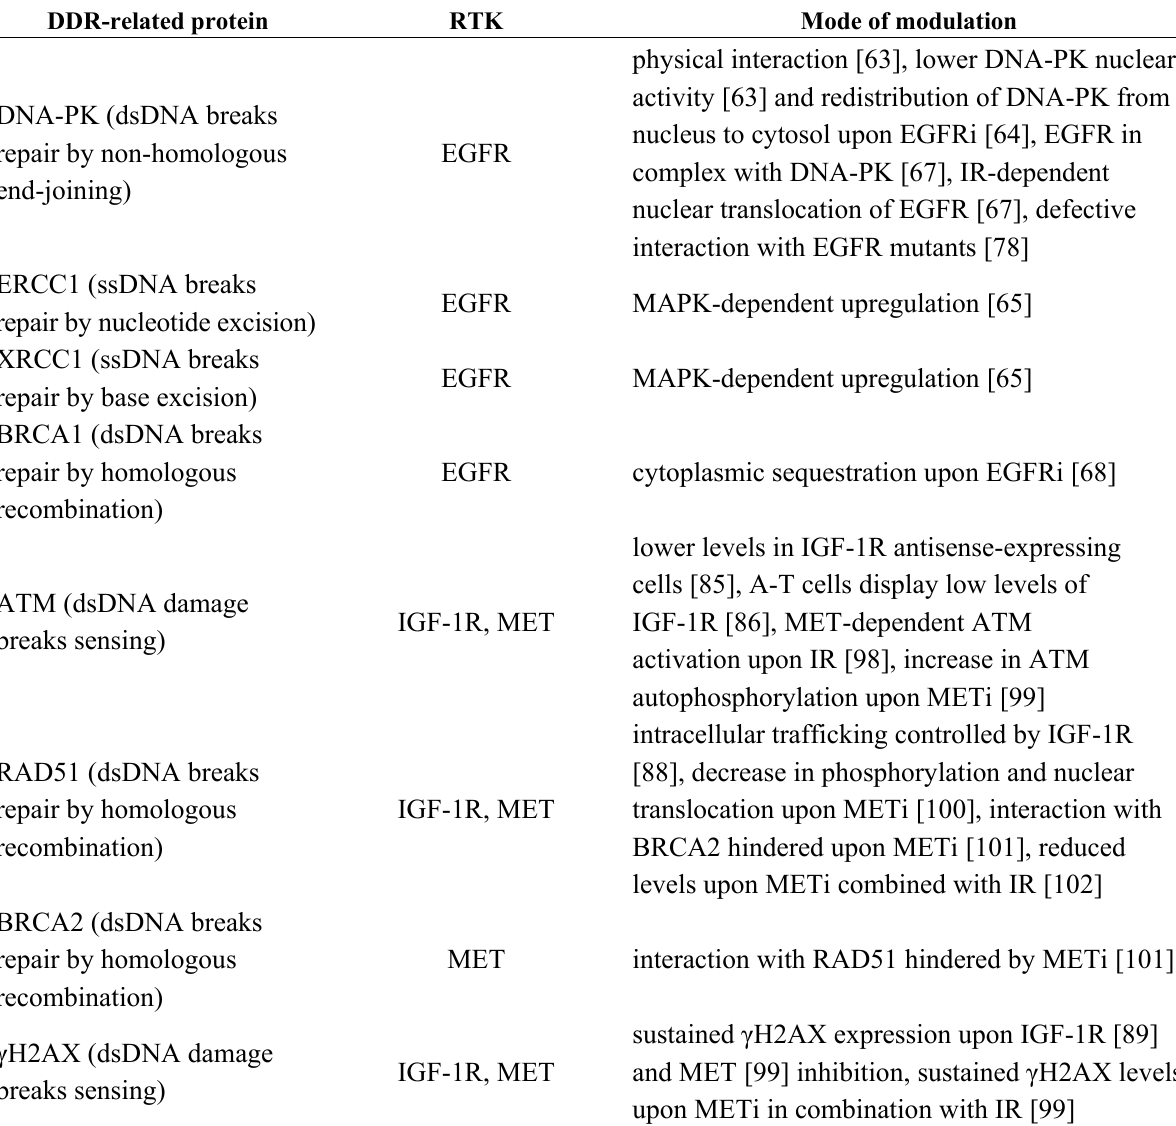
Table 1. Observations linking RTK systems to cellular